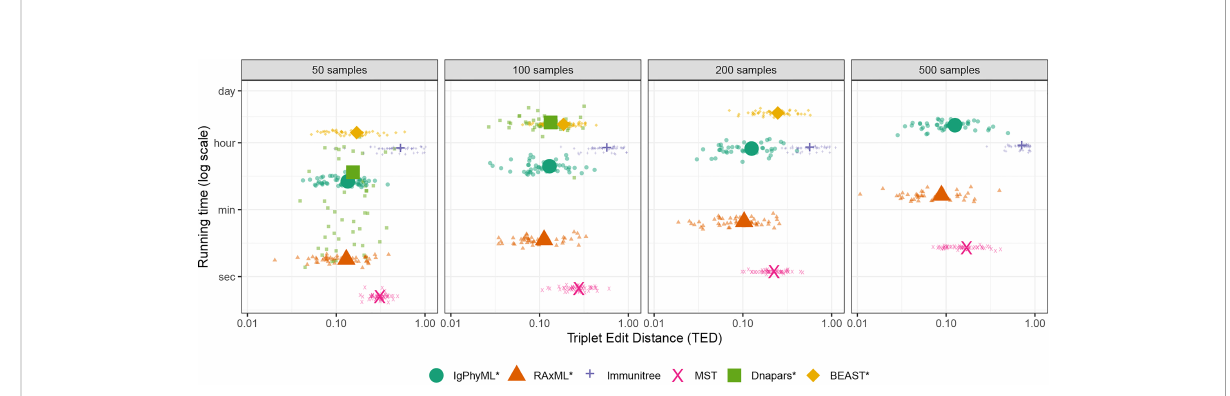
FIGURE 5 Running time and triplet edit distance (TED) of various reconstruction methods on SARS-CoV2 simulations under different sample sizes (50 replicates). Note that contracted methods have the same running time as non-contracted versions are hence are not shown. Also note that GCTree is not included but its running time increases similarly to Dnapare, which it runs